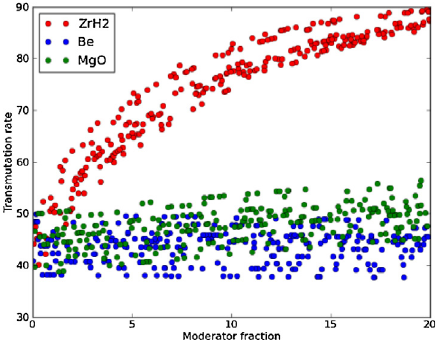
Fig. 2. Transmutation rate versus moderator fraction.